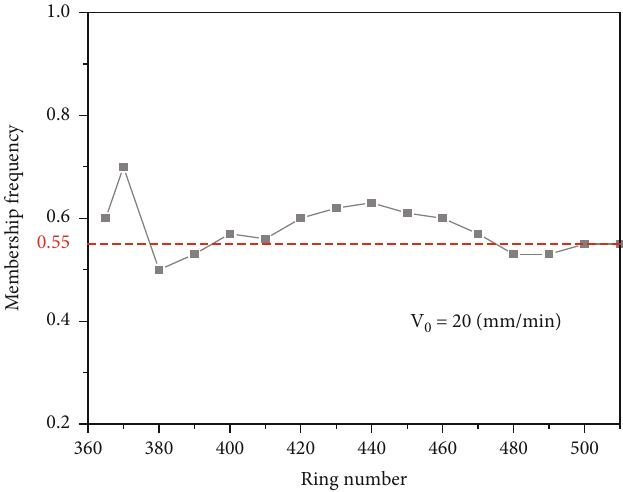
Figure 17: Membership frequency related to the “ reasonable advance speed ” of